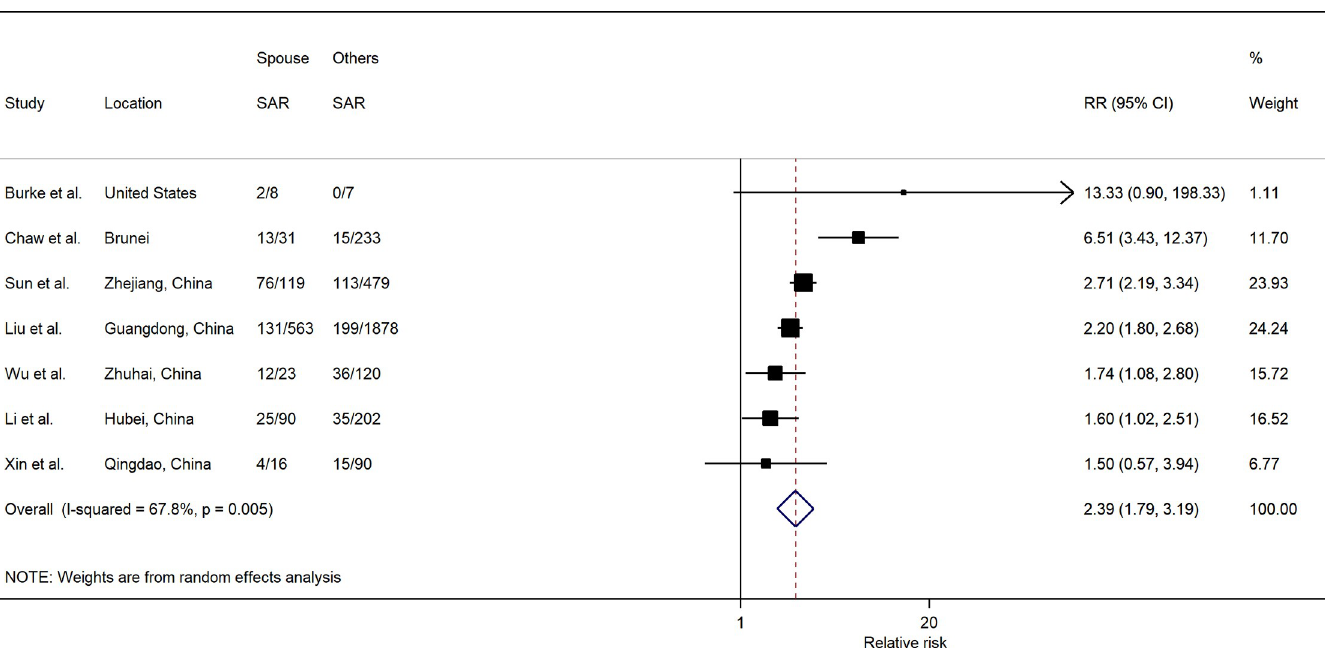
Fig 7. Forest plot of household transmission risk by relationship to index case. RR is the estimated risk ratio, with 95% confidence intervals (CI). I-squared is the percentage of between-study heterogeneity that is attributable to variability in the true effect, rather than sampling variation.